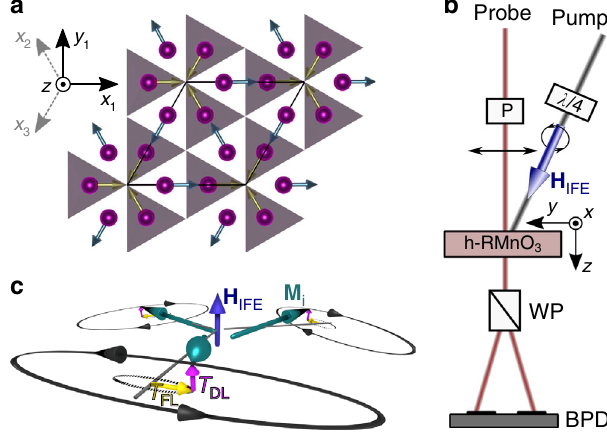
Fig. 1 Experimental geometry. a Projection of the YMnO 3 crystal structure onto the basal plane. Mn 3 + ions (violet) in grey and white areas are located in planes at z = 0 and z = c /2, respectively. The three sublattice magnetisations M i point along equivalent x axes x i as indicated in the coordinate system. Note that spins in HoMnO 3 point along equivalent y axes for T SR < T < T N (Supplementary Fig. 1). b Schematic of the setup. The pump and probe pulses are circularly and linearly polarised, respectively. P polariser, λ /4 quarter-wave plate, WP Wollaston prism, BPD balanced photodiode. c Visualisation of optical Z -mode excitation with fi eld-like and damping-like torques T FL and T DL exerted by the effective fi eld H IFE of k ^ x the IFE on the magnetisation M ( ^ x denotes the unit vector in the i i i direction x i ). Black lines illustrate the ensuing strongly elliptical spin precession. Dashed ellipses show the expected trajectory without spin excitation via T DL . Precession amplitudes are signi fi cantly